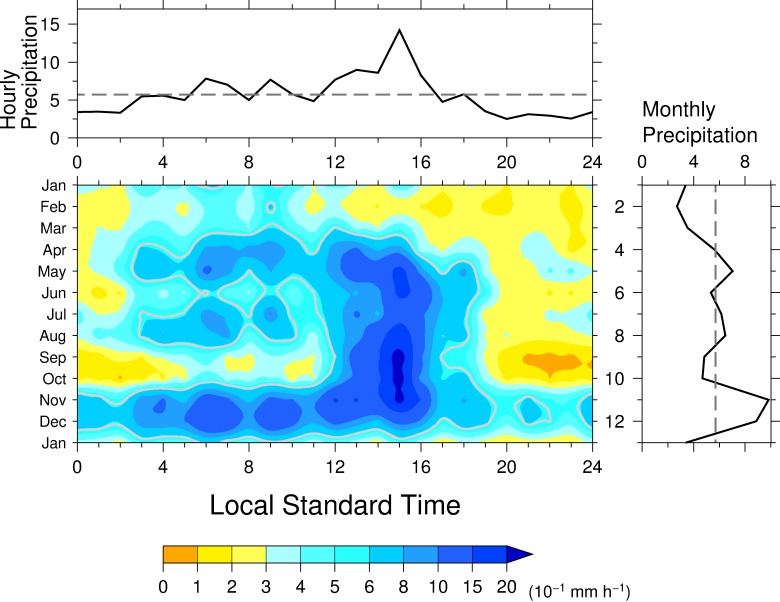
Same as in Fig 2 but for Esperanza.